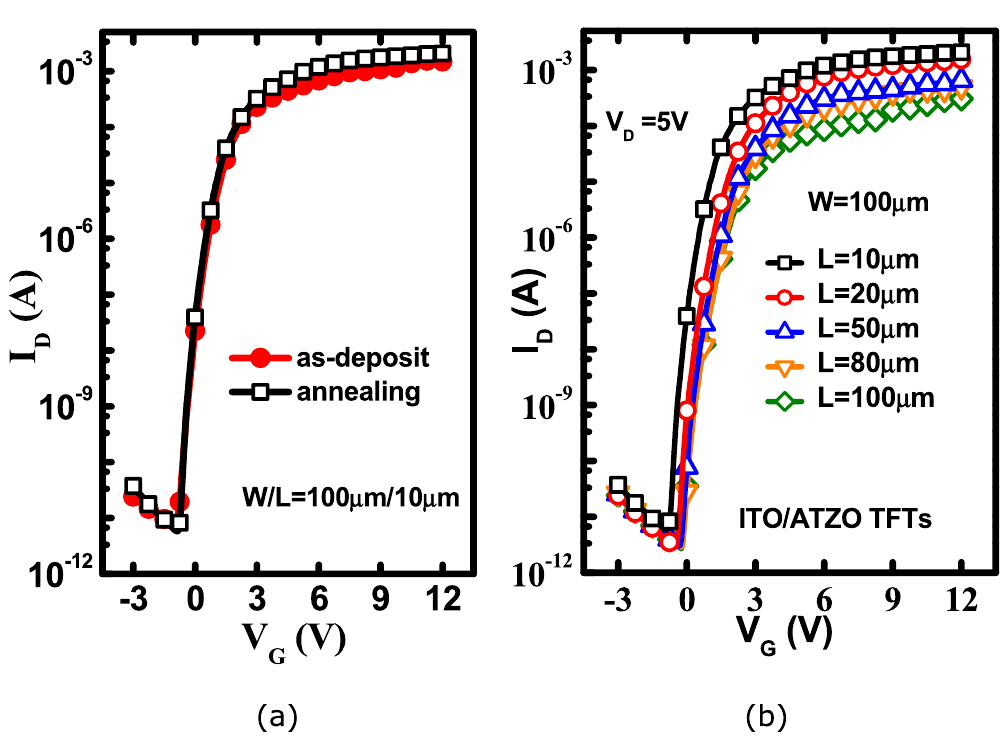
Figure 6. ( a ) Comparison of the transfer curves of the device after annealing. ( b ) Transfer characteristics of the double-channel ITO/ATZO TFTs with various width-to-length